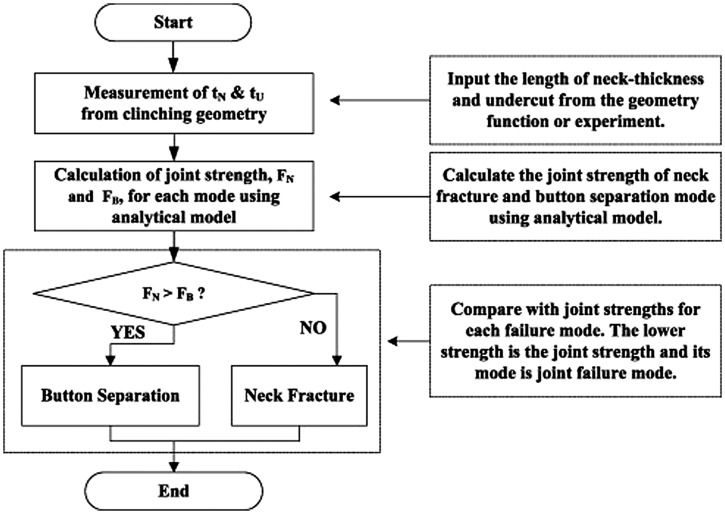
Clinching tools design procedure [66].